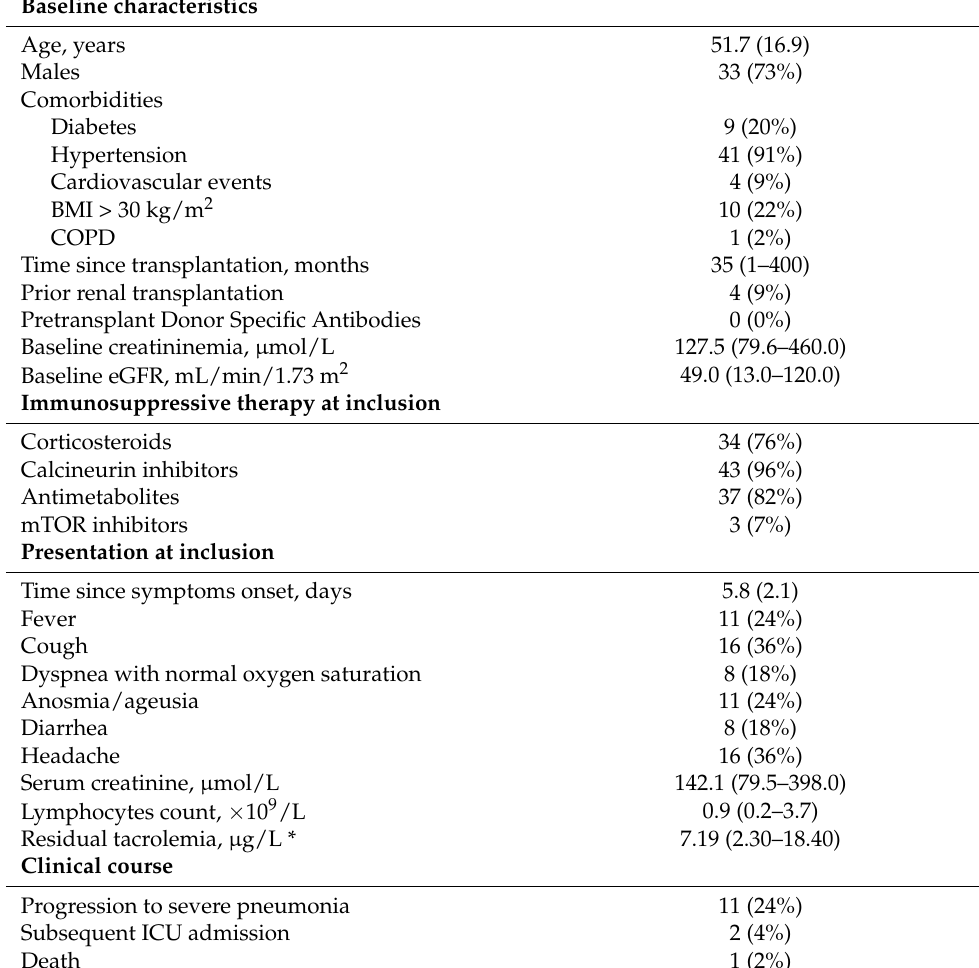
Table 1. Patients’ characteristics at